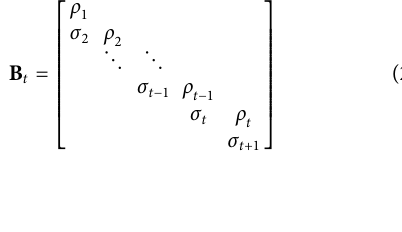
TABLE A1 Calculation algorithm of the Lanczos bidiagonalization. σ w ||, μ 1 = ||d 1 = d w / σ 1 , ν 1 9 =G wT μ 1 , ρ 1 = || ν 1 9 ||, ν 1 = ν 1 9 / ρ 1 for j = 2,3, ...